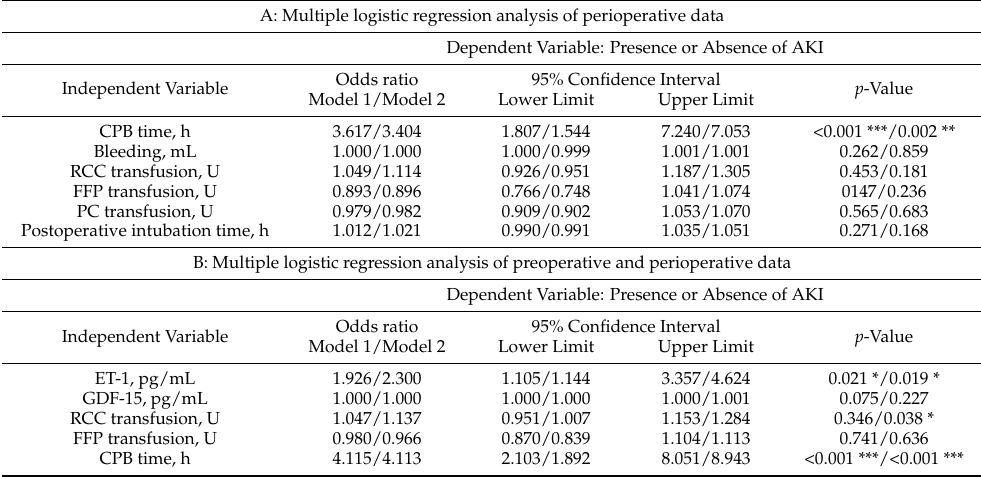
Table 4. Multiple logistic regression analysis of presence or absence of AKI and clinical data.